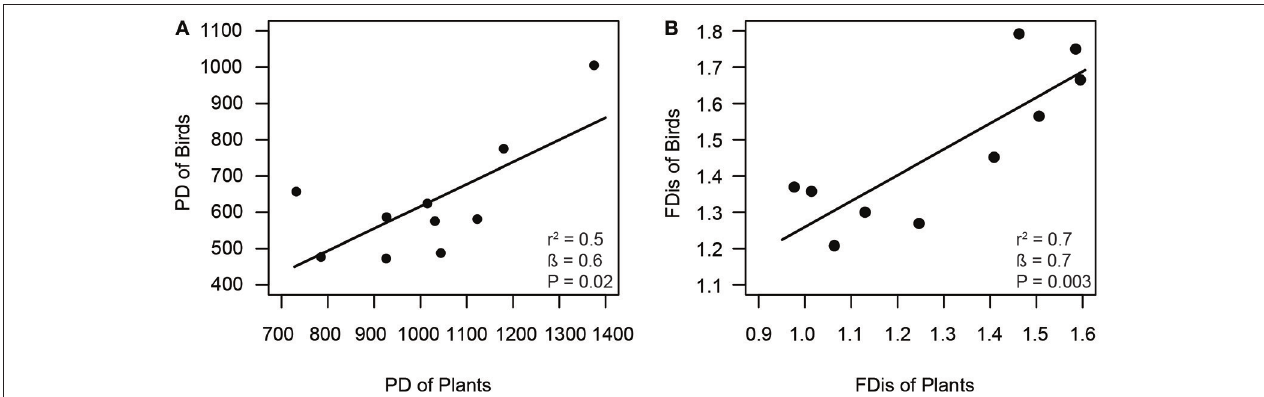
FIGURE 1 | Positive relationship between (A) phylogenetic diversity (PD) and (B) functional dispersion (FDis) of fleshy-fruited adult plant and frugivorous bird communities across ten study plots in the Colombian Andes (elevational range: 1,800–2700m a.s.l.). Shown are results from linear regression models. Given are the overall model fit ( r 2 ) and the estimated slope ( β ) with its associated P -value; solid lines indicate the predicted trend lines.